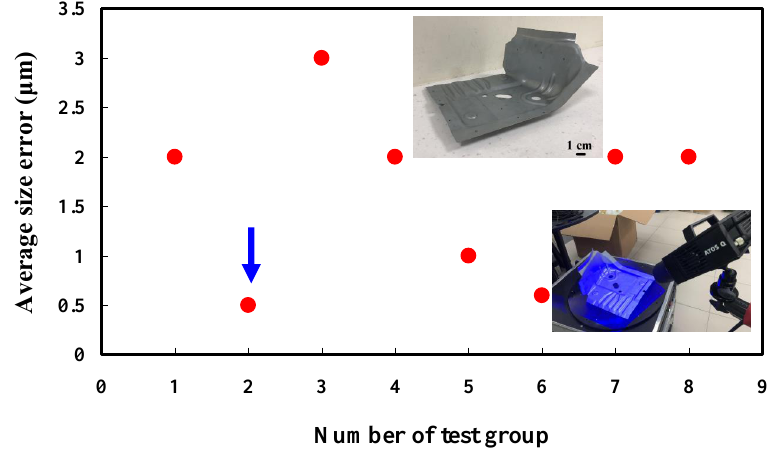
Figure 15. Average size error of the eight test groups compared to conventional method for the glossy sheet metal. The fourth measurement object is a circuit board [20] having uneven surface. Espe- cially, the circuit board has many reflections because there are many electronic compo- nents on the surface. Figure 16 shows the measurement results of the circuit board that was sprayed with a mixture of TiO 2 powder and ethanol before optical measurements. The number of captured points is approximately 356,560 using the high quality function. Figure 17 shows the measurement results of the circuit board that was not sprayed with a mixture of ethanol and TiO 2 powder. The numbers of captured points for eight different measurement methods are approximately 362,830, 384,853, 362,855, 370,602, 311,140, 329,956, 301,302, and 345,667, respectively. Figure 18 shows the CAV results of the circuit board. The color deviation map represents the CAV results compared with the nominal model. Note that the incomplete geometry derived from data omission at the edge of the measurement object was the most serious for the test group numbers 1, 3, 5, and 7. The main reason is that these four methods use one exposure time. The control group is con- sidered as the nominal model and the color deviation map stands for the measurement results deviated from the nominal model. Figure 19 shows average size error of the eight test groups compared to conventional method for the circuit board. Compared to the over- all measurement results from the control group, the average size errors of the eight test groups are approximately 14 µm, 11 µm, 11 µm, 16 µm, 10 µm, 12 µm, 10 µm, and 9 µm, respectively. It is obvious that the average size error of the 3D optical measurement pa- rameters using number 8 of the test group is the lowest because the average size error is only 9 µm. This means that the suggested measurement parameters for the as-cast turbine blade that was not sprayed with anything involve full resolution, more point, two expo- sure times, scan all with reflection detection, and ambient light off.